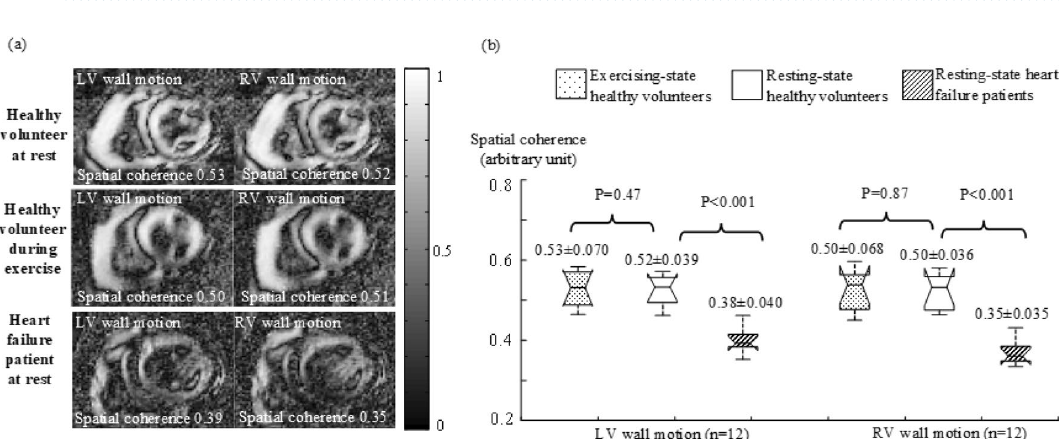
Figure 4. ( a ) Examples of correlation maps with spatial coherence measurements for LV and RV wall motion. ( b ) Box plots of spatial coherence measurements in real-time images from the healthy volunteers and HF patients. Each box provides the median, 25th and 75th percentiles of the measurements and the numbers give the mean ± standard deviation, and the t -test P values (n =